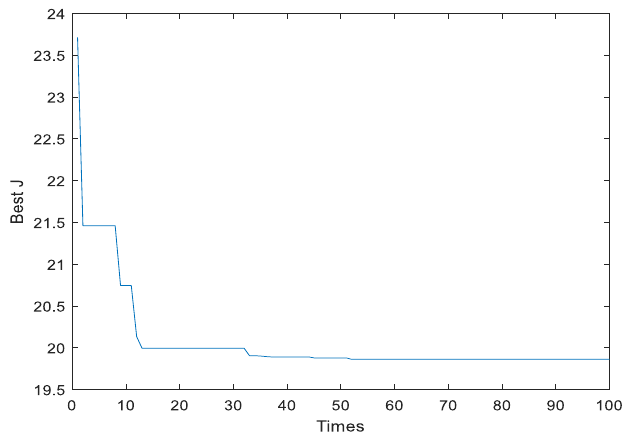
Figure 9. Iterative curve of the GA.